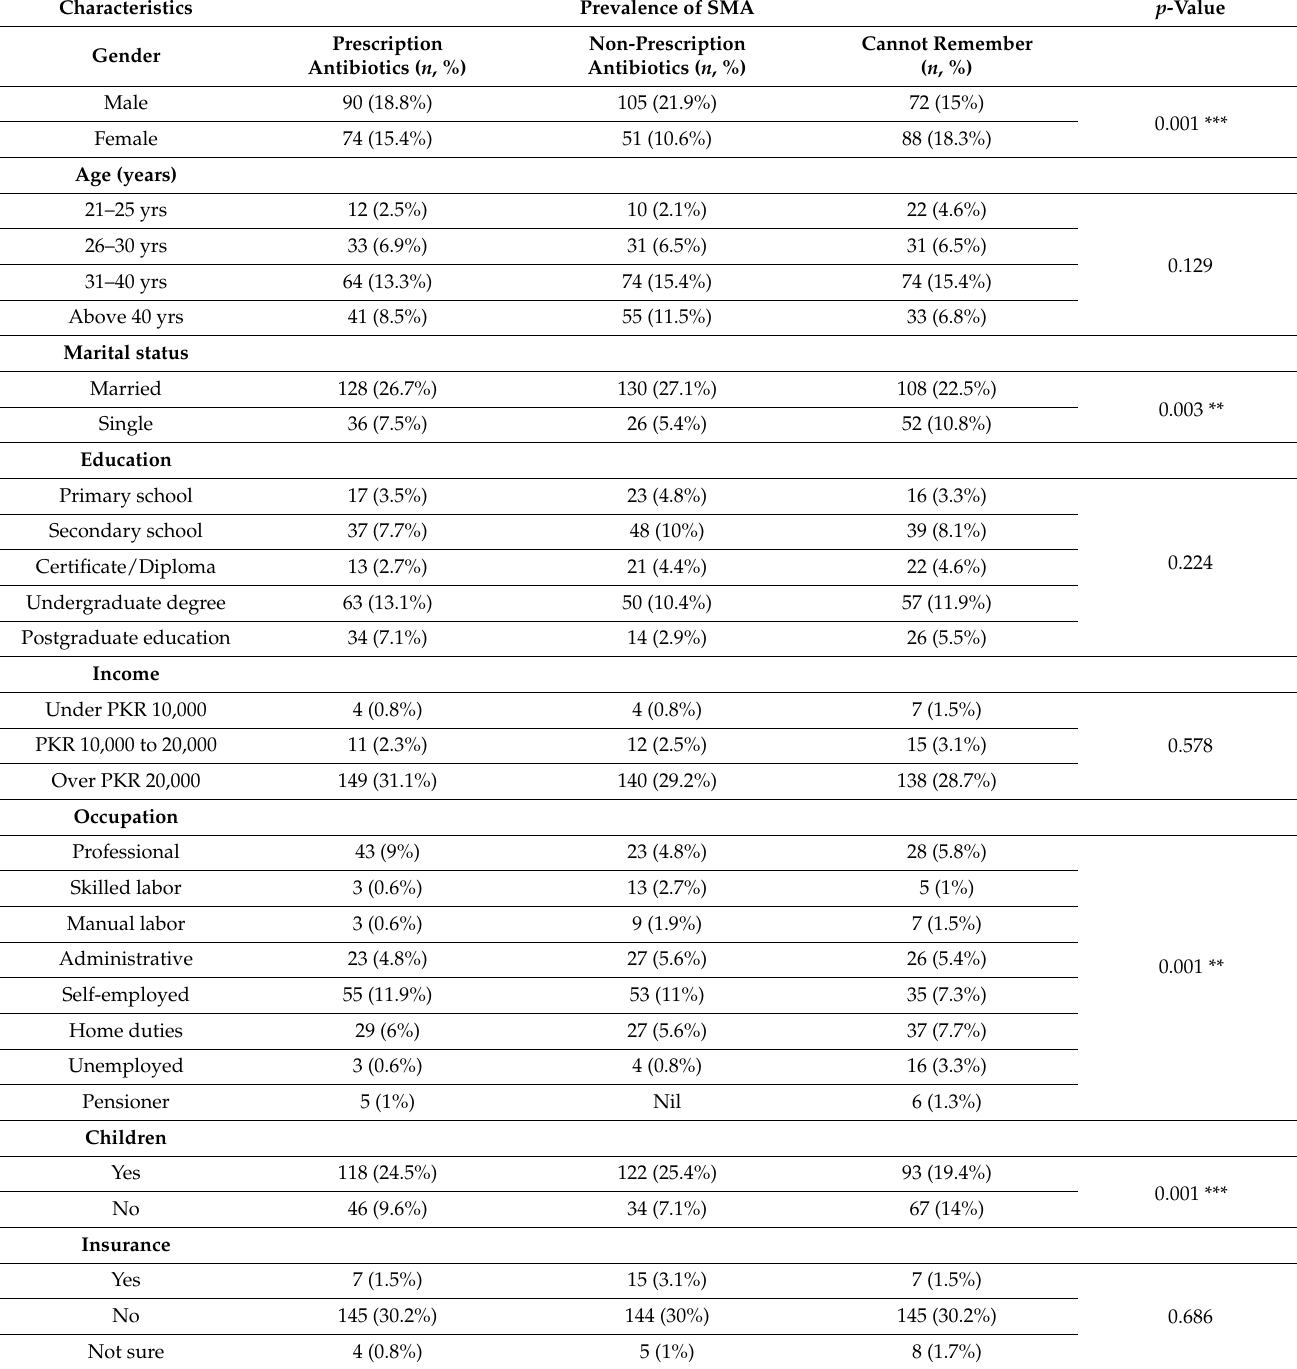
Table 2. Prevalence of SMA and associated demographic